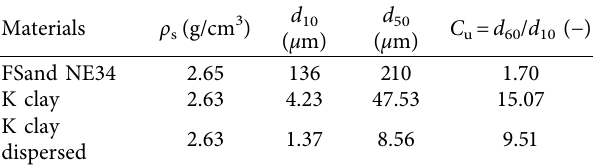
Table 1: Physical parameters of FSand NE 34 and K